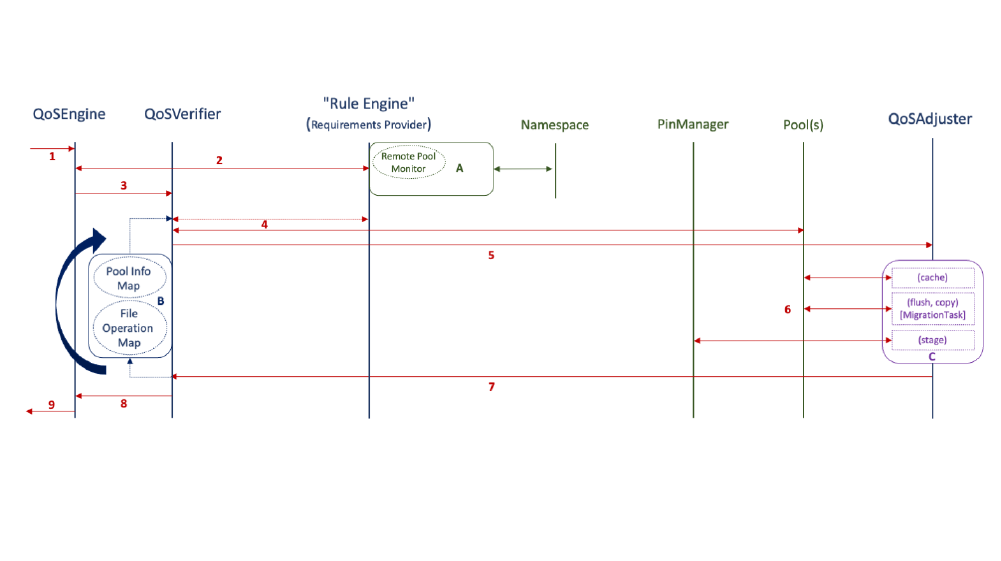
Figure 5. QoS Request Handling. A - the current rule engine uses the namespace and Pool Selection Unit. B - The pool selection is done by the verifier and sent as part of the message to the adjuster; verifier keeps track of maximum running slots and only sends ready tasks to the adjuster. C - The adjuster queues the requests, maps them to adjuster types and executes; the types call out to either the pools or the